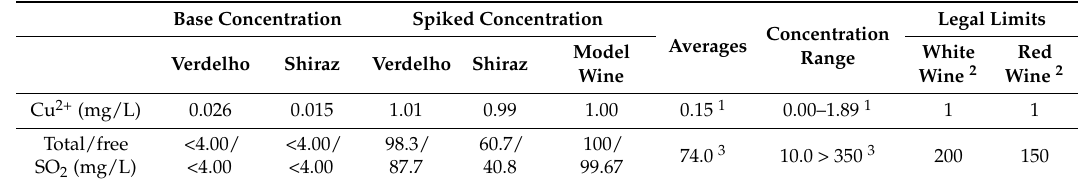
Table 3. Concentrations of Cu 2+ and SO 2 in the base wines, spiked samples and average metal and SO 2 concentrations for Australian